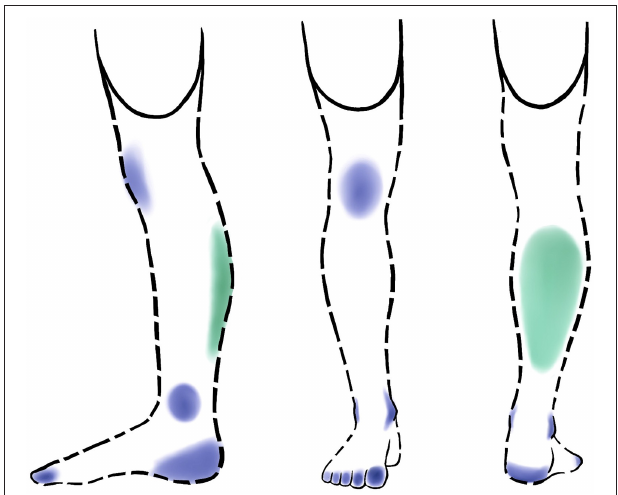
FIGURE 5 | Location of the participant’s phantom sensations and the nature of the sensations (green: muscle contractions; blue: tingling) in a sitting position and without a prosthesis. In the standing position with a prosthesis and when walking, the areas are perceived more intensely and the locations are similar, except for the knee which is no longer perceived. Solid outline: residual limb; dashed outline: amputated